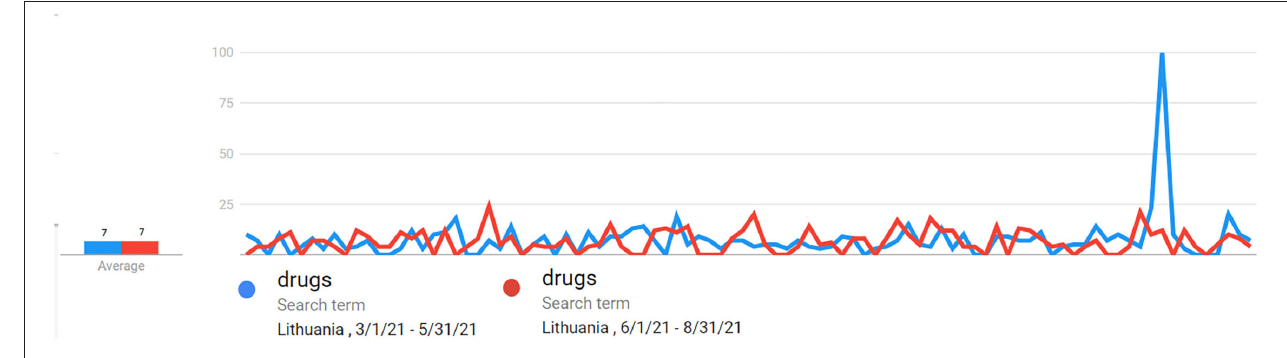
FIGURE 3 | Seasonality impact